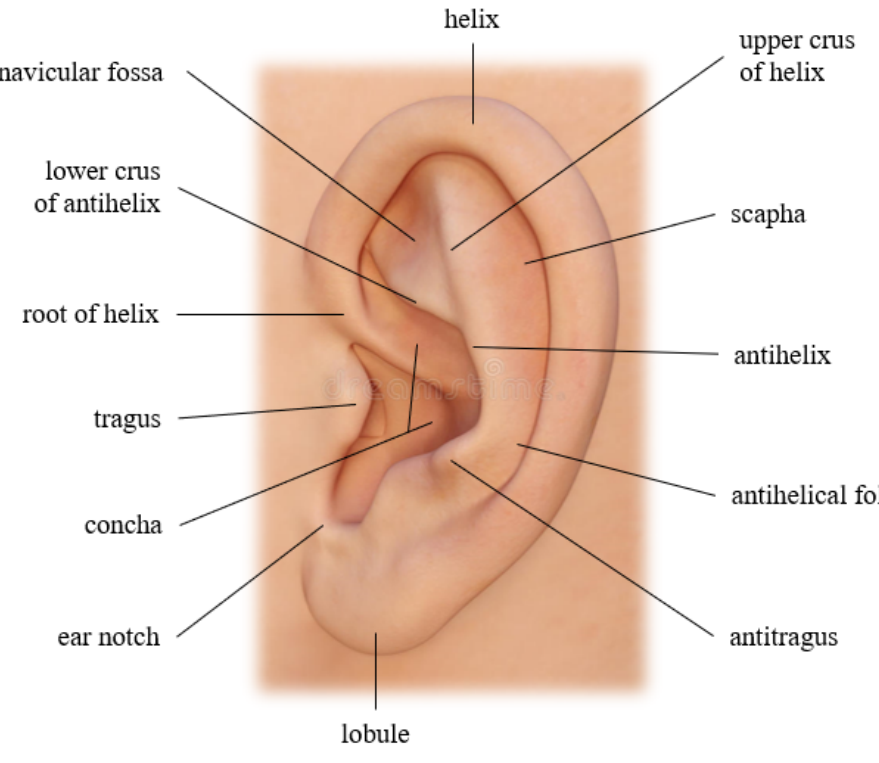
Figure 1. Outer ear structure, image elaborated by the